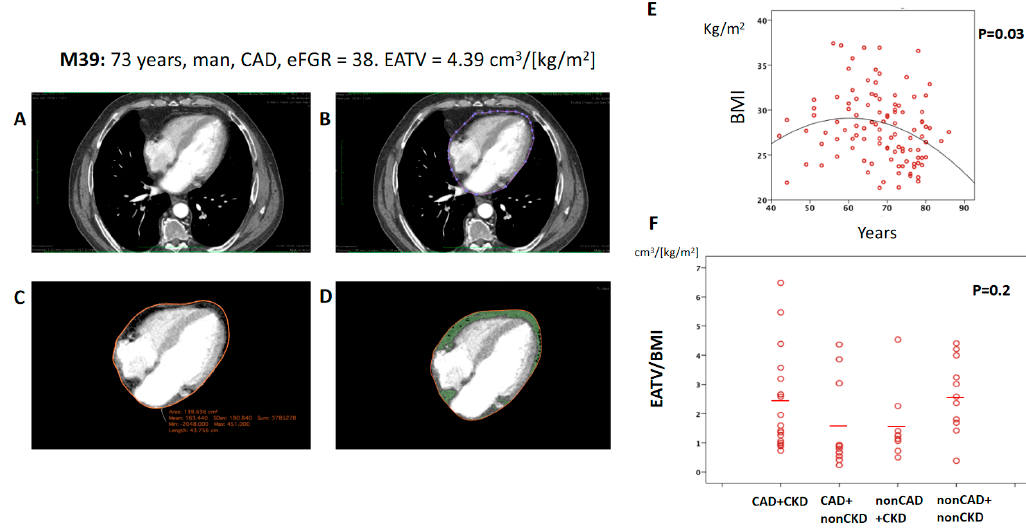
Figure 1. Measurement of the epicardial adipose tissue volume (EATV) in a non-contrast cardiac computed tomography. Measurements were performed as described in the Methods section number 4.4. Briefly, ( A ): representative image of a non-contrast cardiac computed tomography from the patient M39 of the current study, ( B , C ): tracking the contour of the pericardium (blue dots in B and continuous orange line in ( C ) to measure total epicardial adipose tissue volume in ( D ) using a semi-quantitative measurement of the epicardial fat volume (EFV) with Horos TM (Horosproject.org). A minimum of 40 images were used and perivascular fat attenuation was within the threshold range of − 30 to − 250 Hounsfield units. The EFV, marked in green in the figure, was measured in cm 3 . ( E ): Dot-Blot showing an inverted U-shaped relation among BMI and patient age. ( F ): Dot-Blot showing EATV values (indexed to BMI) of the di ff erent groups of this study. Abbreviations: CAD = coronary artery disease, BMI = body mass index, EATV = epicardial adipose tissue volume, eGFR = estimated glomerular filtration rate, NonCKD = patients with eGFR > 60 mL /